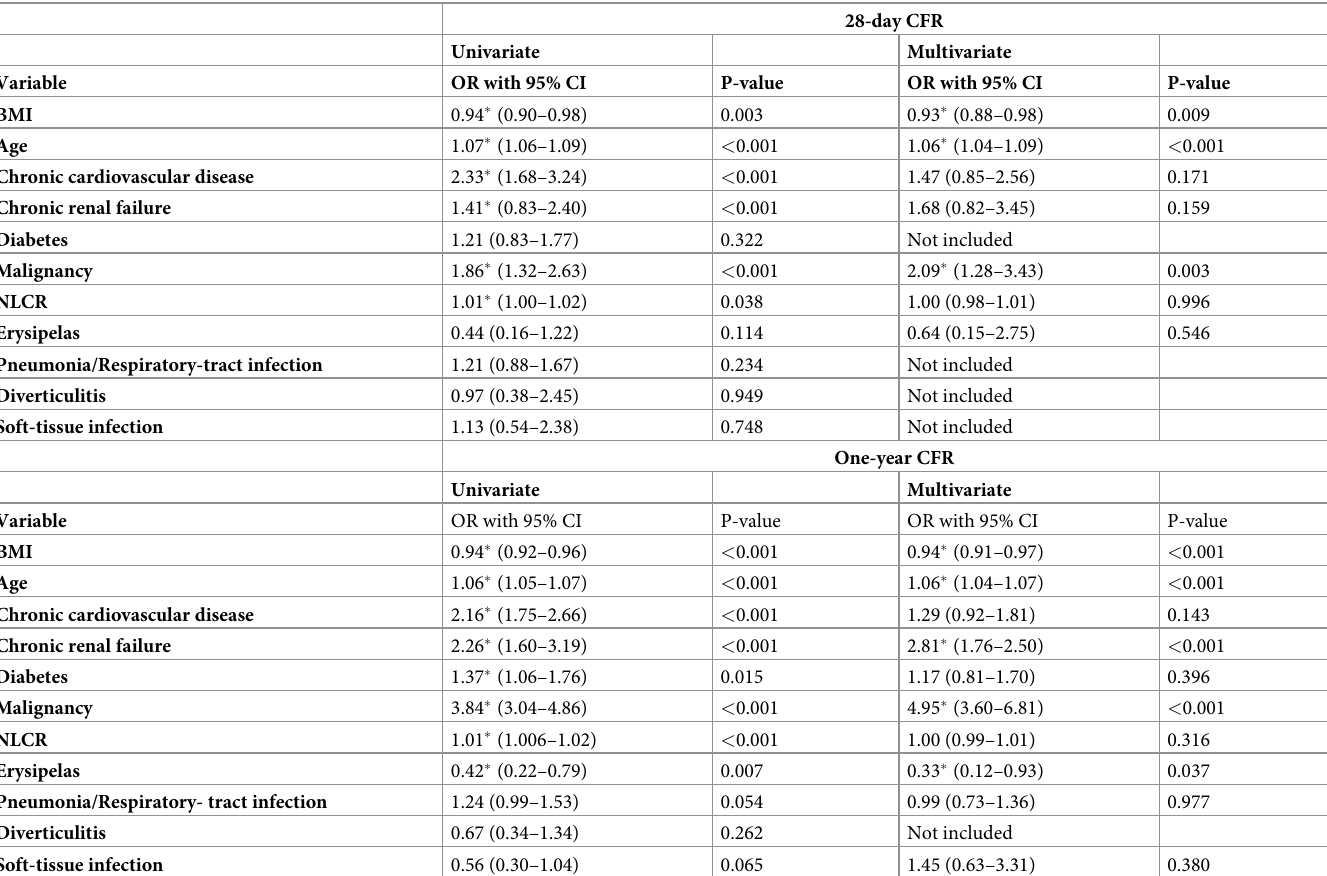
Table 4. Risk factors for 28-day and one-year CFR. Univariate and multivariate logistic regression